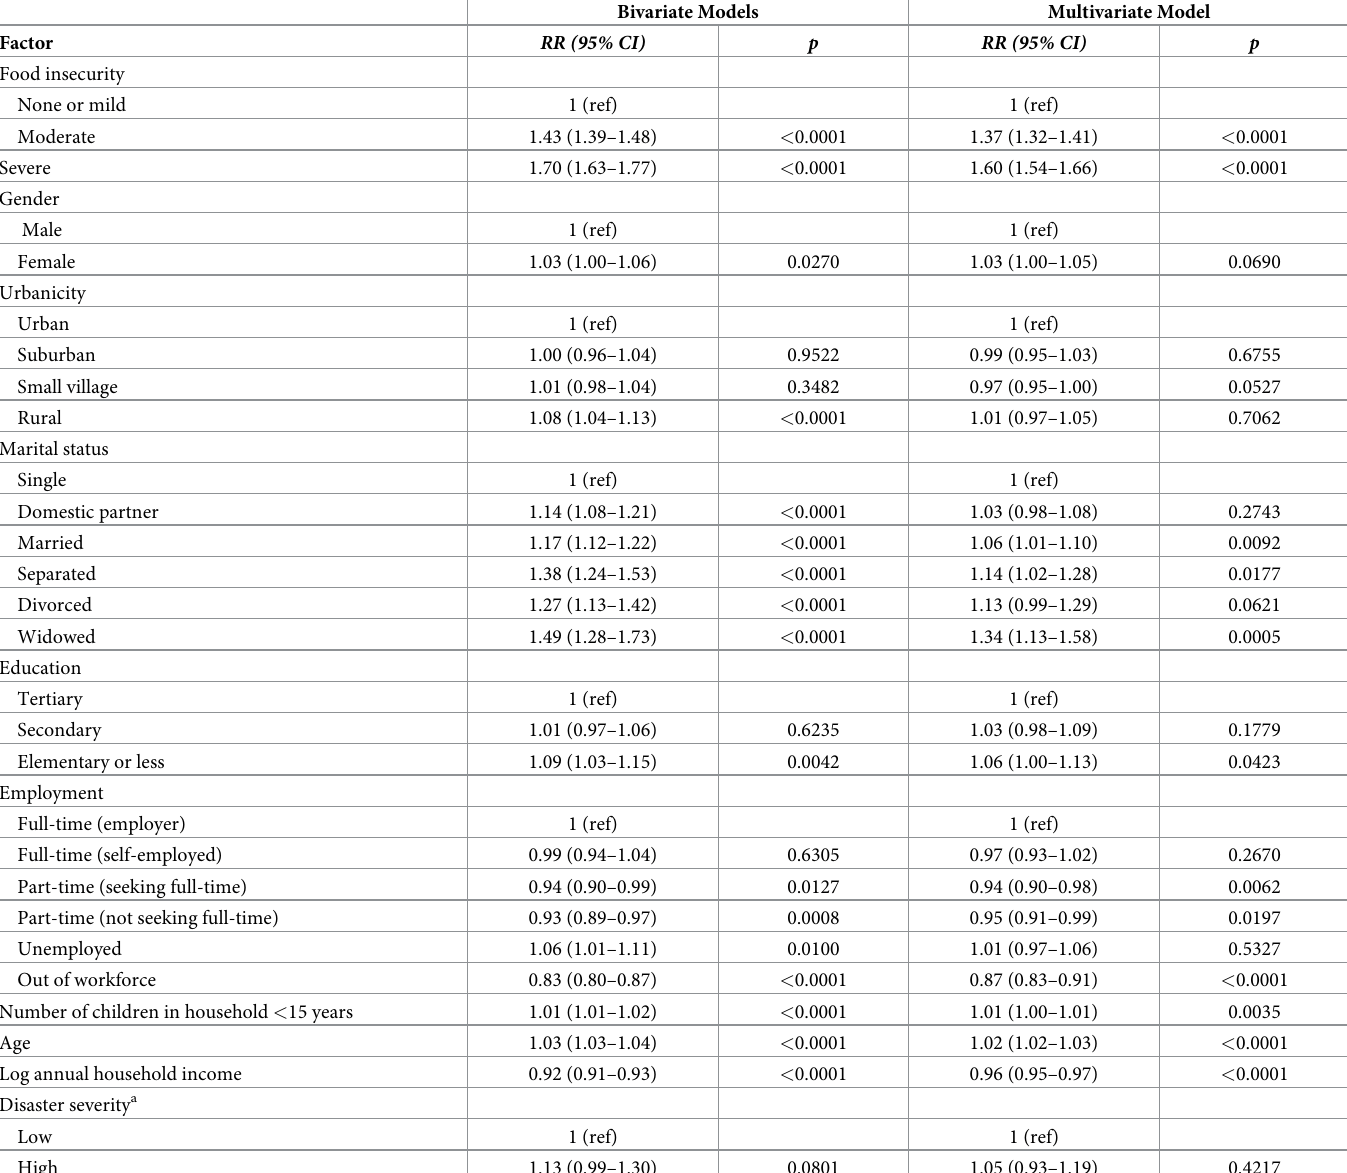
Table 2. Bivariate and multivariate multilevel negative binomial regression models examining the association between food insecurity (Food Insecurity Experiences Scale) and poor mental health (Daily Experience Index score) among n = 28,292 youth from the 2017 Gallup World Poll survey. Bivariate Models Multivariate